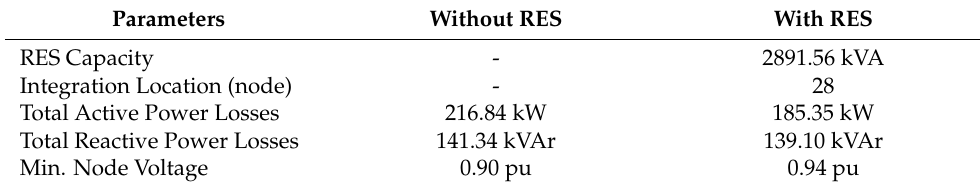
Figure 6. Voltage profile with and without RES. Table 1. Comparison of parameters with and without